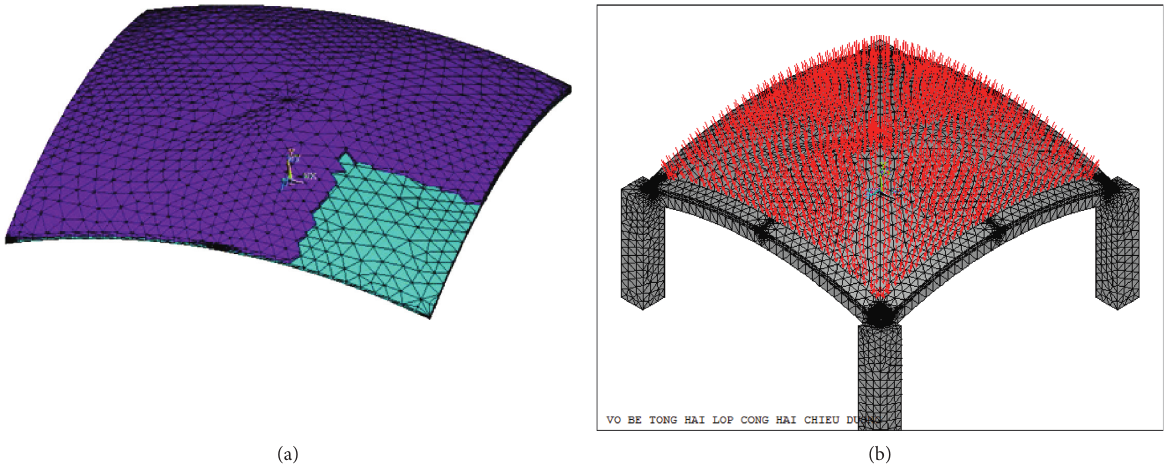
Figure 9: Meshing, boundary of shell, and load. (a) Meshing of elements; (b) boundary of shell and